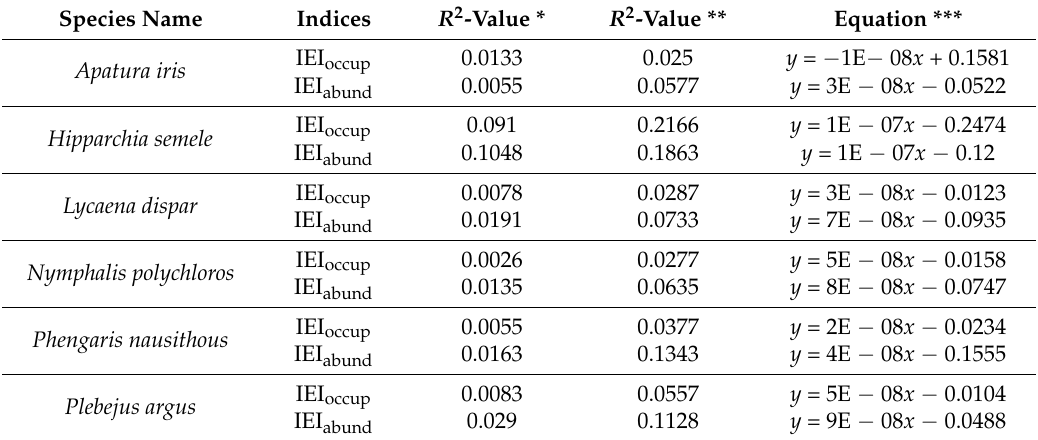
Table 1. Effect of land-cover area (X) on Ivlev’s electivity indices (IEI) ( Y ) values for all butterfly